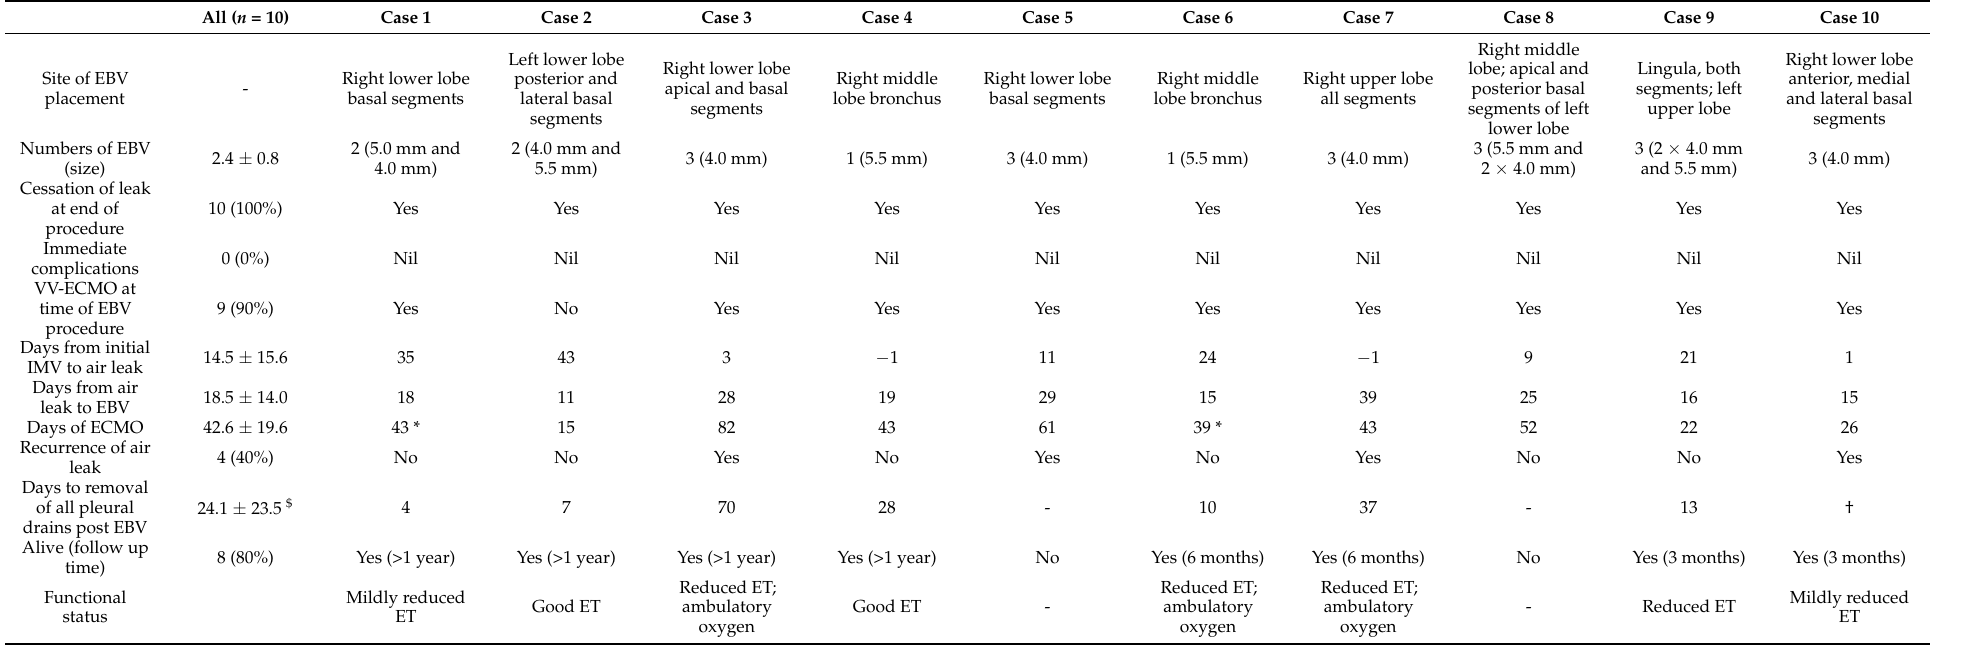
Table 2. EBV procedural details, air leak characteristics, clinical course and